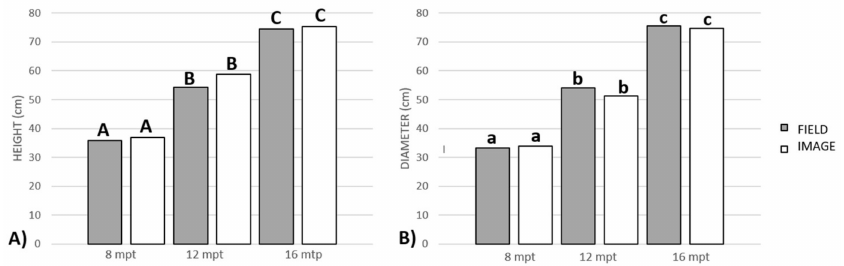
Figure 2. Statistical differences between height ( A ) and crown diameter ( B ), in centimeters (cm), measured in the field and by aerial images for the three periods of study. Legend: Equal letters in the same variable and time of study indicate a non-significant statistical difference at 5% probability according to the t